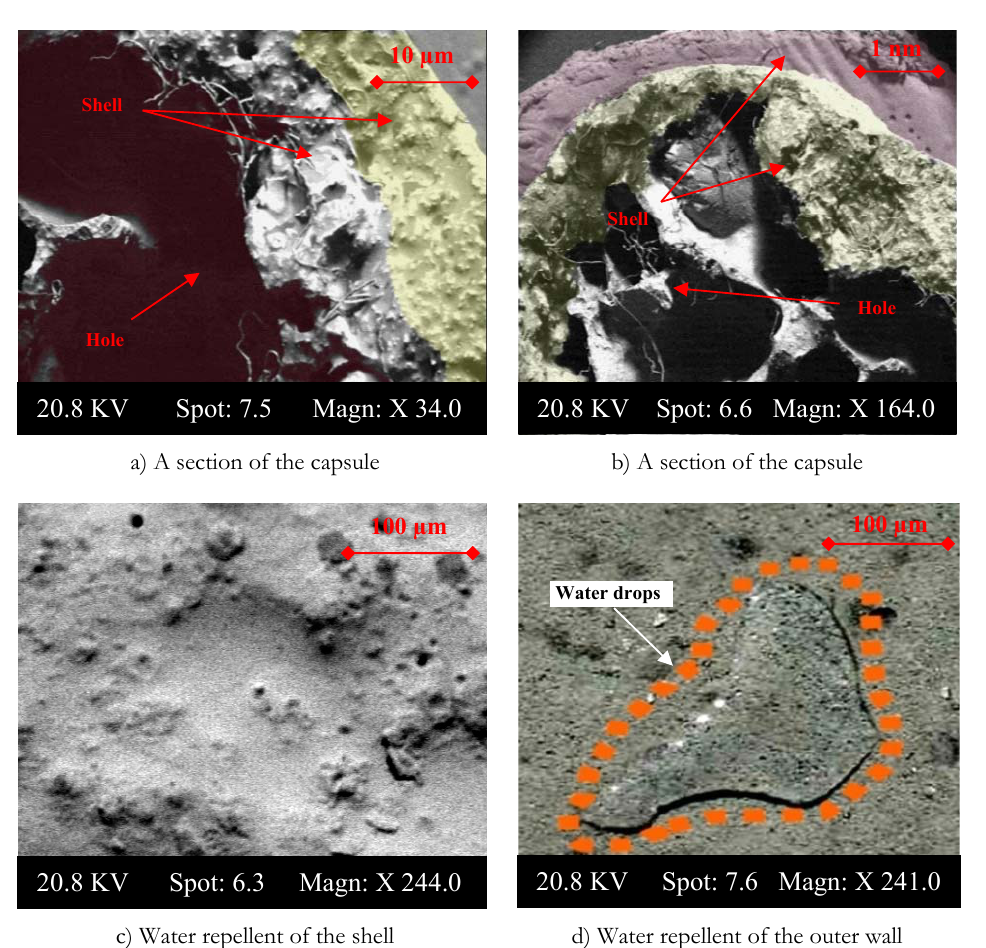
Figure 3: SEM images of